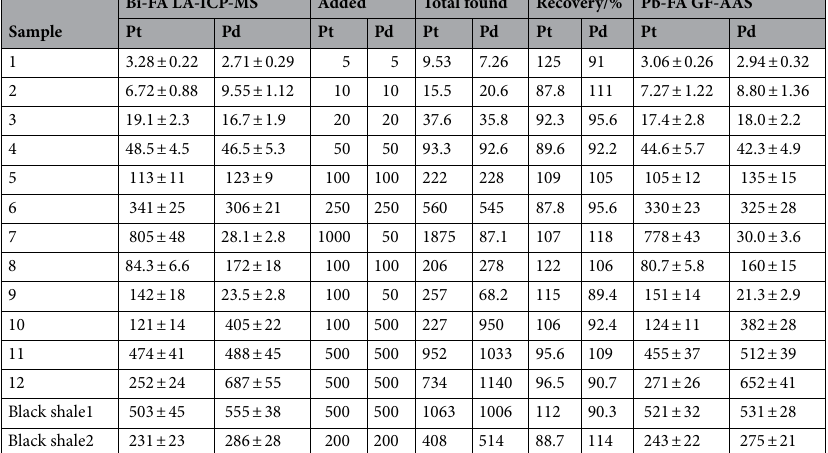
Table 9. Comparison of analytical data for Pt and Pd in real geochemical samples by the proposed Bi-FA LA-ICP-MS and traditional Pb-FA GF-AAS methods (n = 5, ng g −1 ).